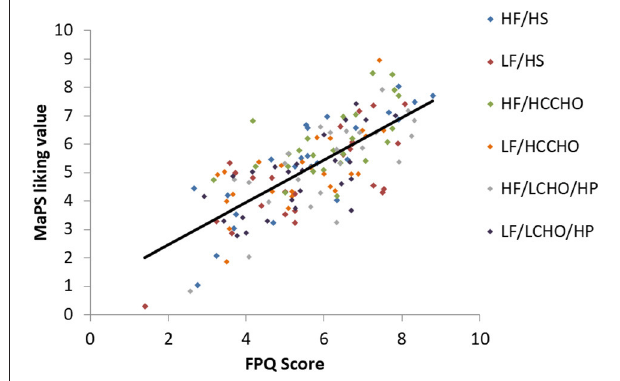
TABLE 3 | Means and standard deviation of image ratings collapsed into carbohydrate categories.